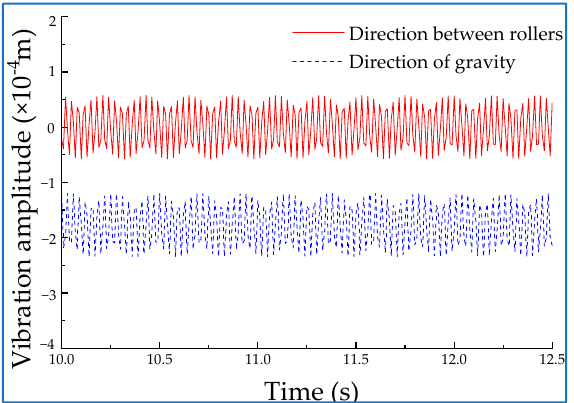
Figure 13. Comparison of vibration amplitudes in the direction between rollers.